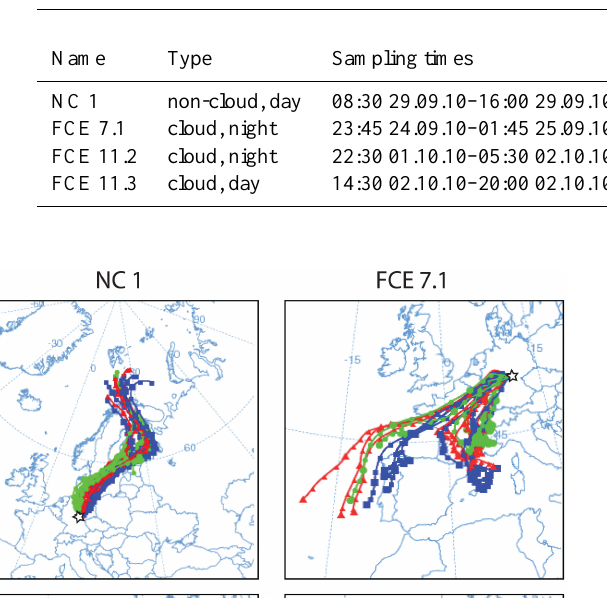
Table 3. Measurement periods for sulfur isotope analysis during the HCCT-2010 campaign. Times are Central European Summer Time (CEST). Liquid water content and temperature (at Schmücke) and upwind [SO 2 ] represent average values for the measurement period. Connected flow analyses are only available for cloud events.